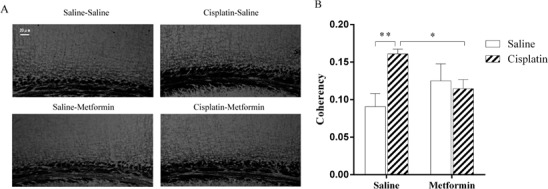
Effects of cisplatin and co-administration of metformin on the organization of myelin basic protein-positive fibers in the cingulate cortex.Mice were treated with cisplatin and metformin and brains were collected after behavioral analysis. MBP staining patterns in the cingulate cortex were analyzed as a measure of integrity of myelinated fiber networks. (A) Representative examples. (B) Pictures of all sections were captured using a Leica microscope and quantified by Fuji ImageJ with a coherency plugin. Data were analyzed by two-way ANOVA (cisplatin×metformin, F(1,15) = 17.36, p<0.01) followed by Tukey post hoc testing. Scale Bar: 20μm. All data are expressed as mean±SEM. *, p<0.05; **,p<0.01. n = 4–5 per group